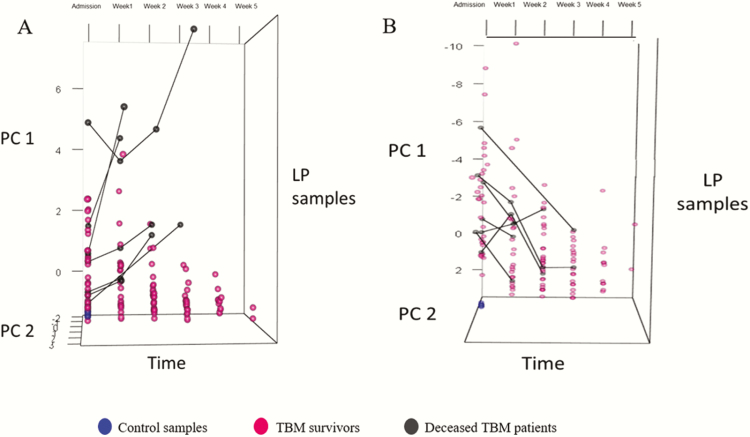
PCA plot: Temporal profile of combined neuromarkers in lumbar puncture (LP) cerebrospinal fluid (CSF) samples. These 3-dimensional principal component analysis (PCA) plots depict the z scores for combined neuromarkers (A) and combined inflammatory markers (B) in lumbar CSF over the duration of sampling (admission to week 5). Each circle represents a patient’s z score at that time point. The axes represent principal component 1 (PC1), principal component 2 (PC2), and time. A, Patients who died (indicated by circles joined by lines) had increasing neuromarker trends, whereas survivors demonstrated a decline in concentrations over time. B, Overall, patients who died (indicated by circles joined by lines) had decreasing inflammatory marker trends, similar to survivors. Abbreviation: TBM, tuberculous meningitis.